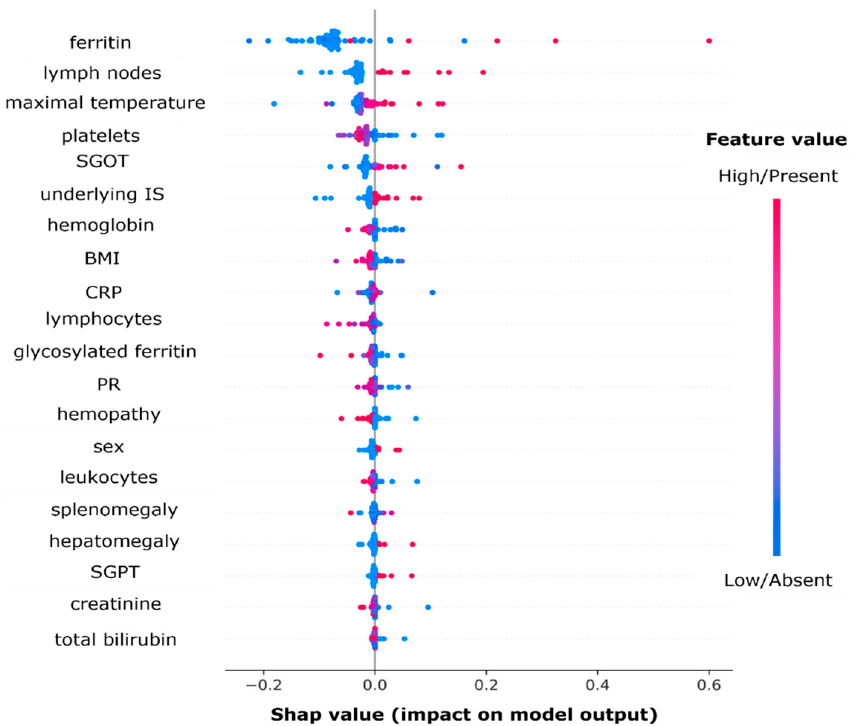
Figure 3. Beeswarm plot of Shap values for all patients and for each feature. The right side of the plot favors the output “HLH” and the left side favors the output “not HLH”. The gradient color corresponds to the feature value (dark pink if high or present for categorical features and blue if low or absent for categorical features). Abbreviations: BMI: body mass index; CRP: C reactive protein; PR: prothrombin rate; SGOT/AST: serum glutamic-oxaloacetic transaminase; and SGPT/ALT: serum glutamic-pyruvate transaminase.